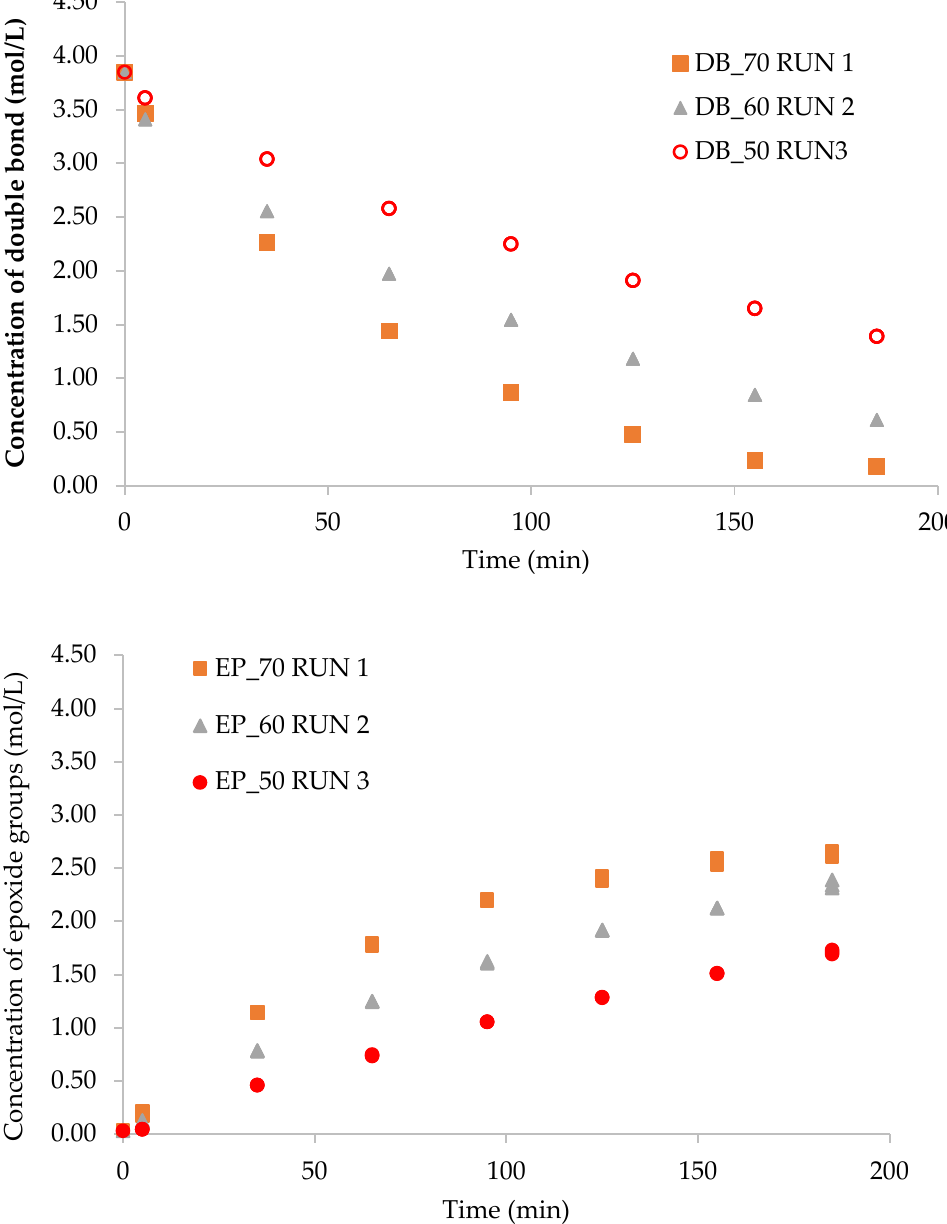
Figure 6. Effect of reaction temperature on the rate of epoxidation.